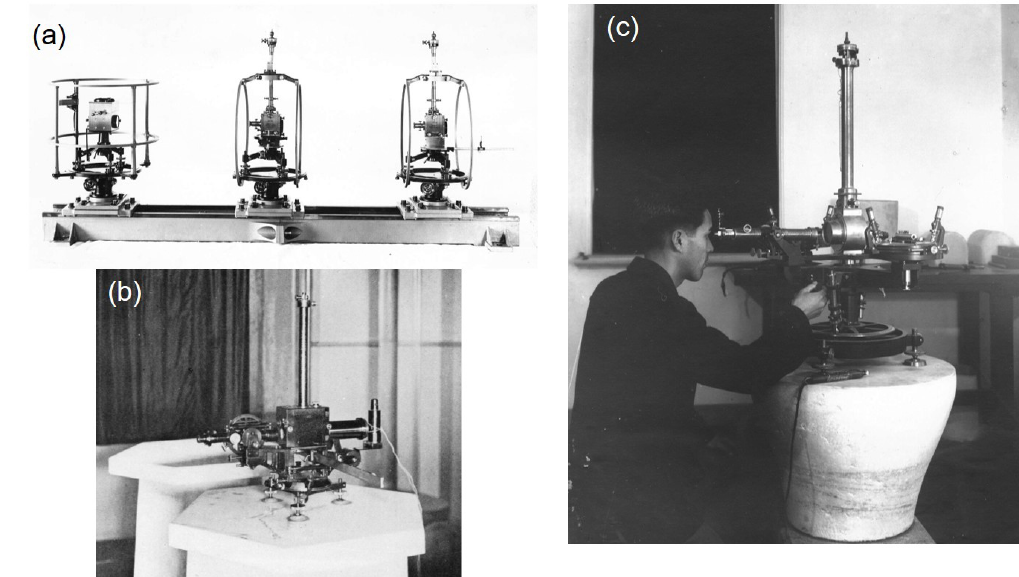
Figure 10. (a) Eshenhagen–Schmitt variometers, (b) an Indian survey pattern magnetometer, and (c) a Schmitt theodolite for the declination during an observation in 1952 (photo supplied by Kakioka Magnetic Observatory).